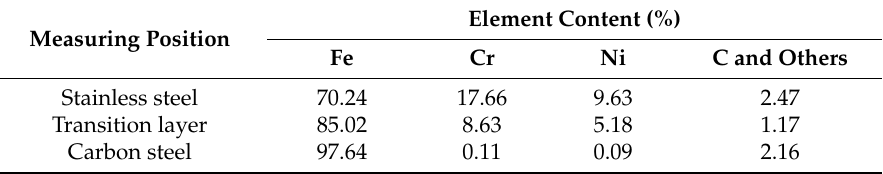
Table 2. Energy dispersive spectrometer analysis.